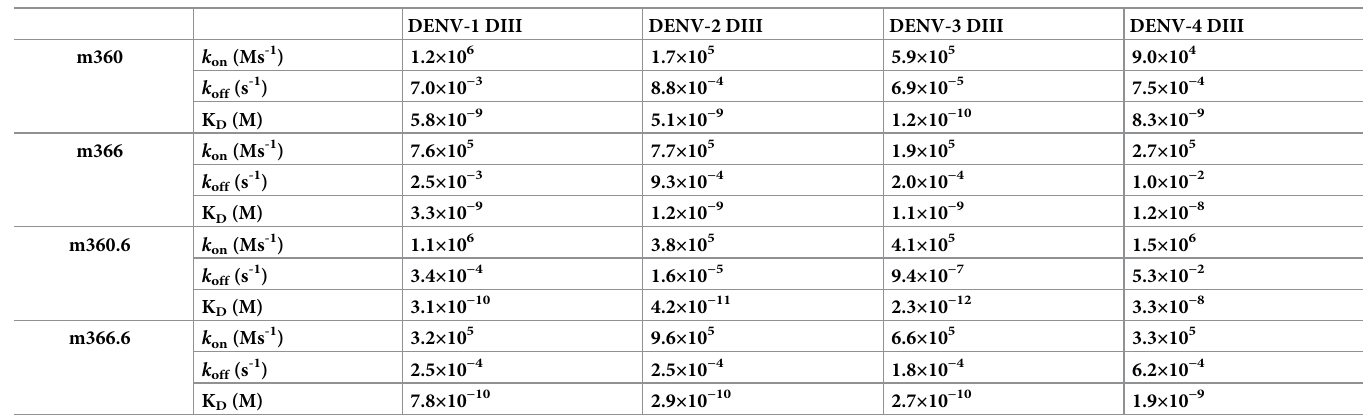
Table 1. Binding kinetics of DENV1-4 DIII-specific mAbs measured by